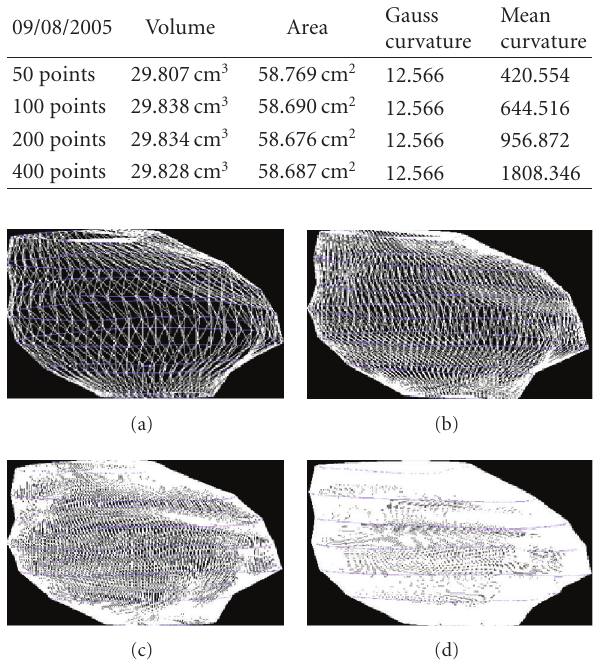
Figure 22: Patient 2. (a) 50 points on the contours, (b) 100 points on the contours, (c) 200 points on the contours, and (d) 400 points on the contours.